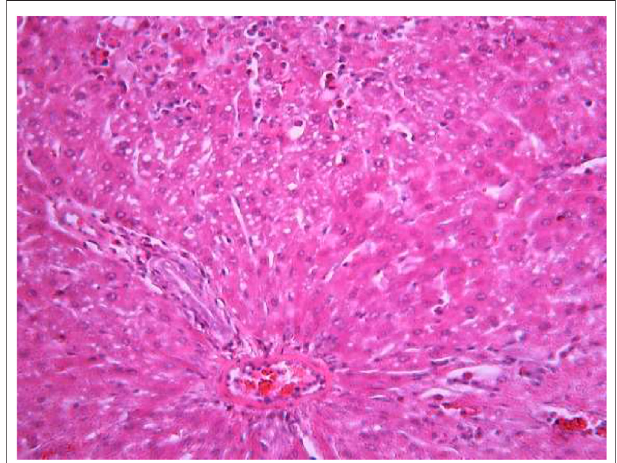
FIGURE 10 | Liver tissue. The administration of the honey extract. Restoration of the linear cord structure of the hepatic lobule; the nuclei are located in the cell center; a few hepatocytes in the state of ballooning degeneration. Stain: hemotoxin and eosin. Magni fi cation × 400.